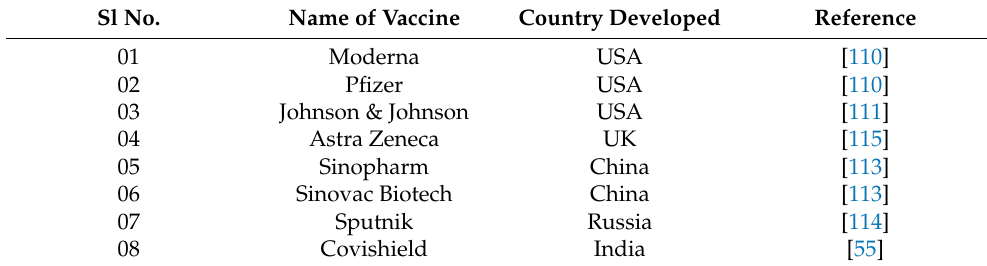
Table 2. List of various vaccines developed to tackle COVID-19. Sl